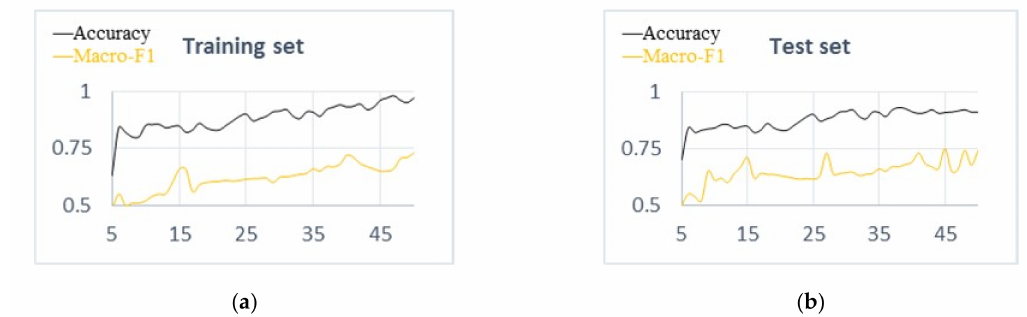
Figure 4. ( a ) The training dataset comparison. ( b ) The test dataset comparison.